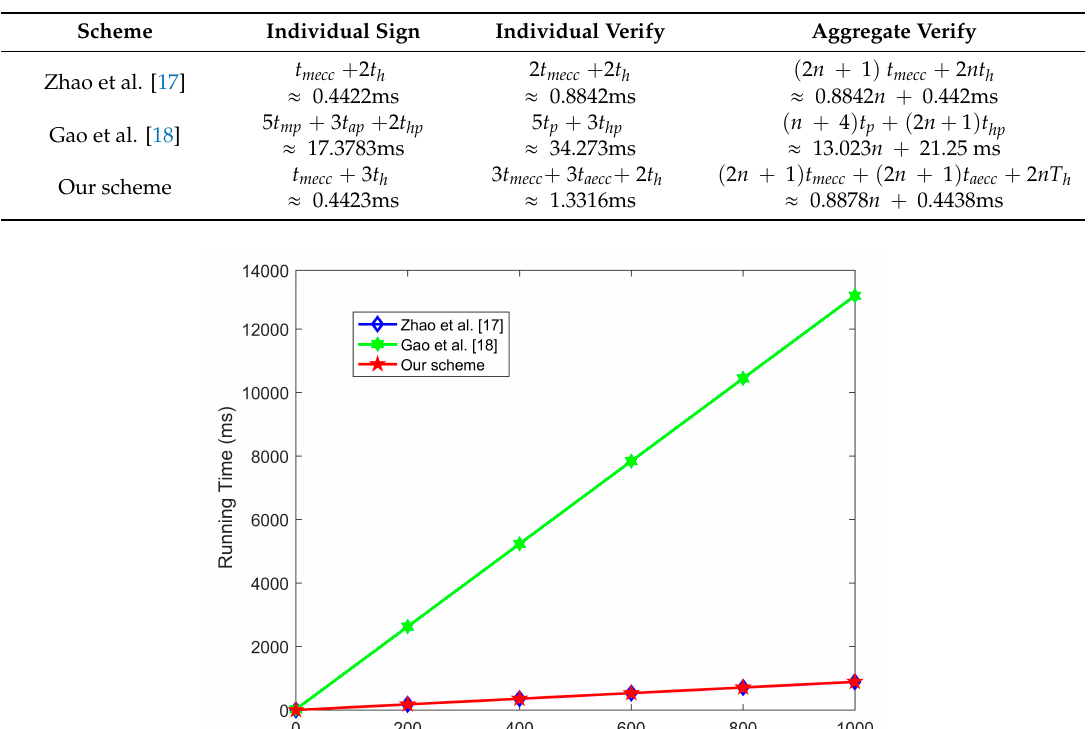
Table 8. Communication cost of schemes based on blockchain.